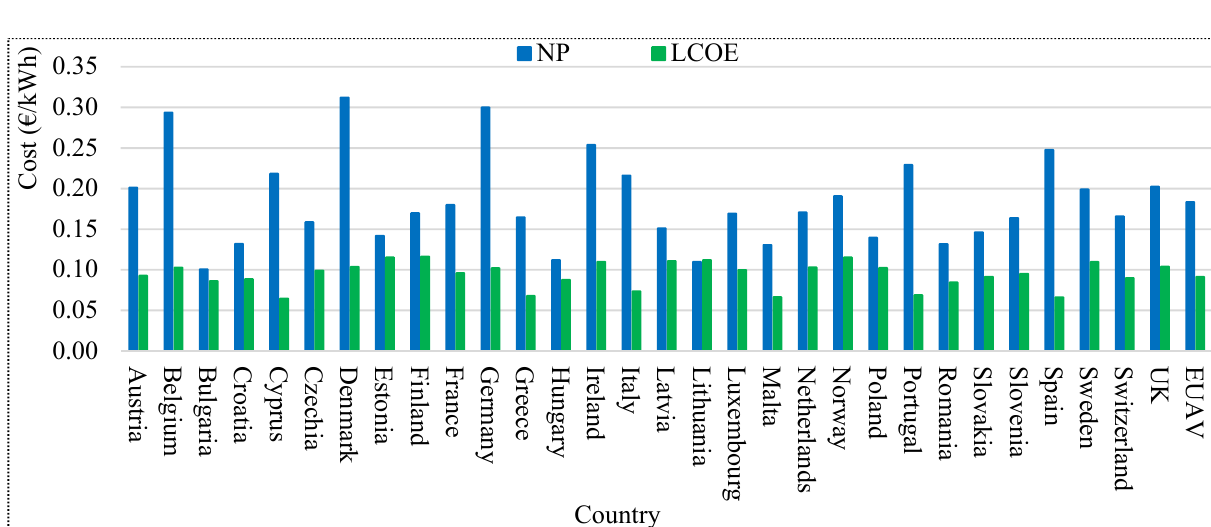
Figure 5. NP and LCOE in Scenario 2.